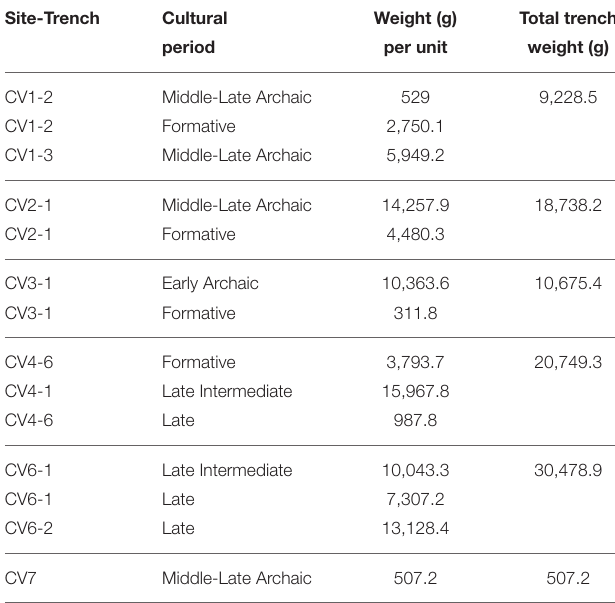
TABLE 3 | Total biomass (g) per site and trench for eight taxa recorded in shellfish assemblages from Caleta Vitor.